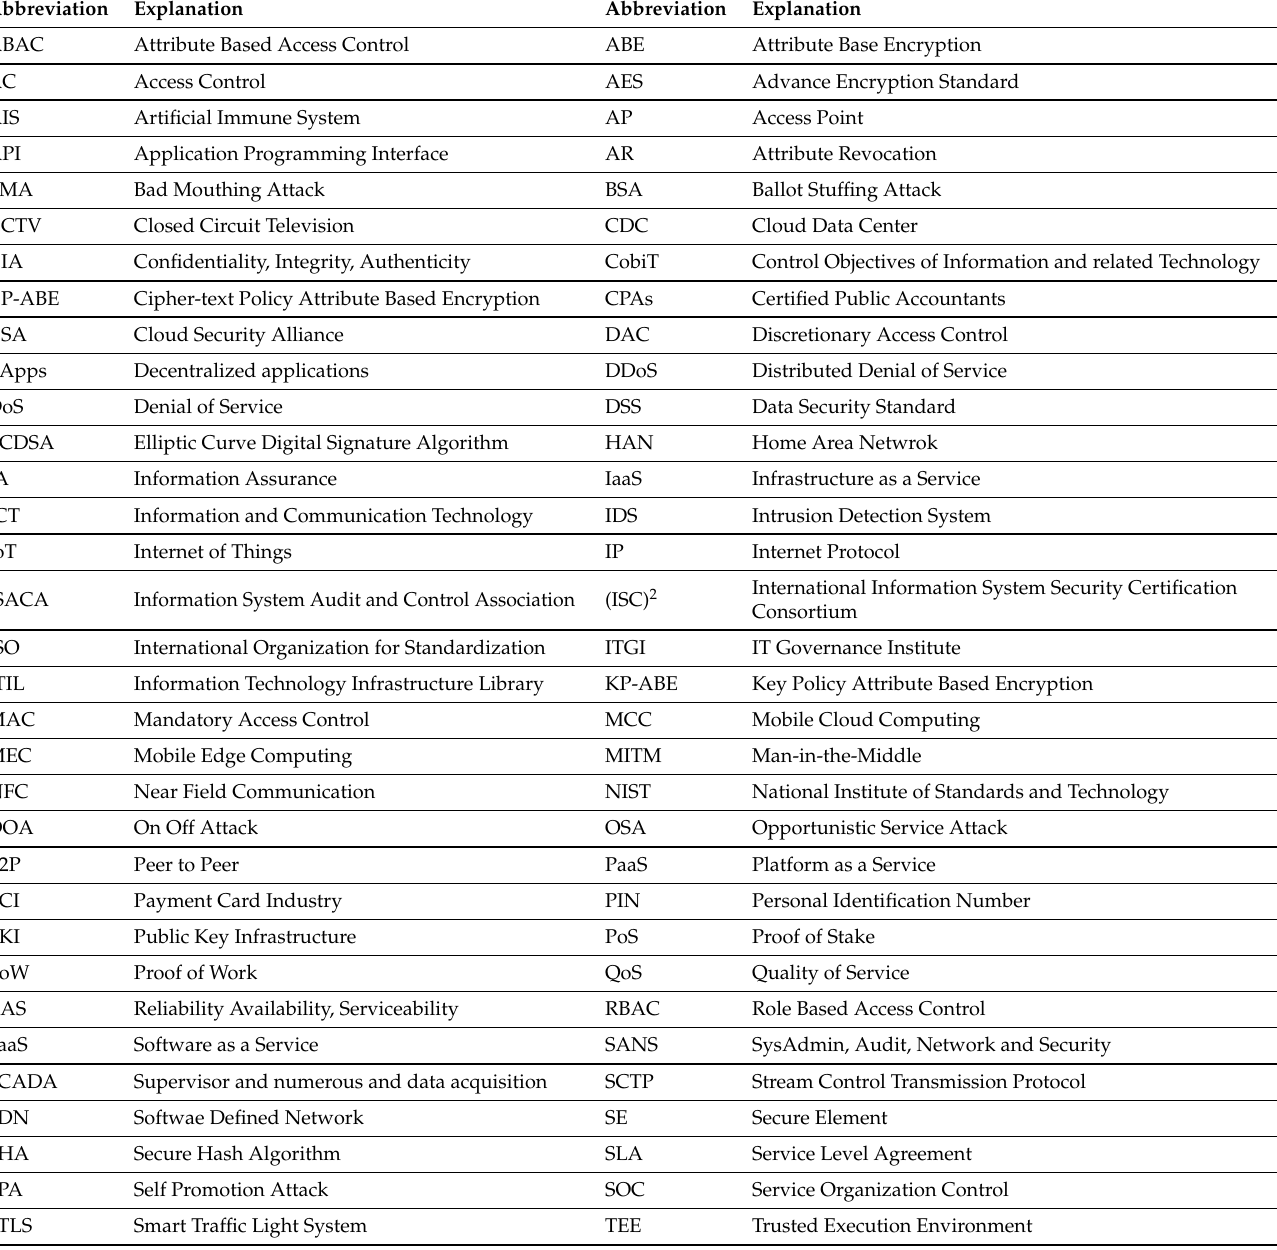
Table 1. List of